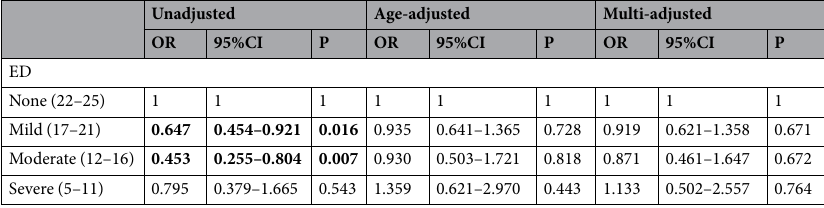
Table 3. The multinomial logistic regression analysis for the association between ED and osteocalcin. * ED is divided into four groups according to the IIEF-5 scores: None = 22–25 scores, Mild = 17–21 scores, Moderate = 12–16 scores and Severe = 5–11 scores. None ED is treated as the reference. * ED: erectile dysfunction; BMI: body mass index; WHR: waist hip rate; OR: odd ratio; 95%CI: 95% confidence interval.